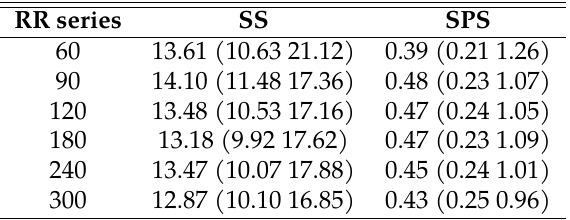
Table 3: SS and SPS indicators of RR series, median (1st; 3rd)